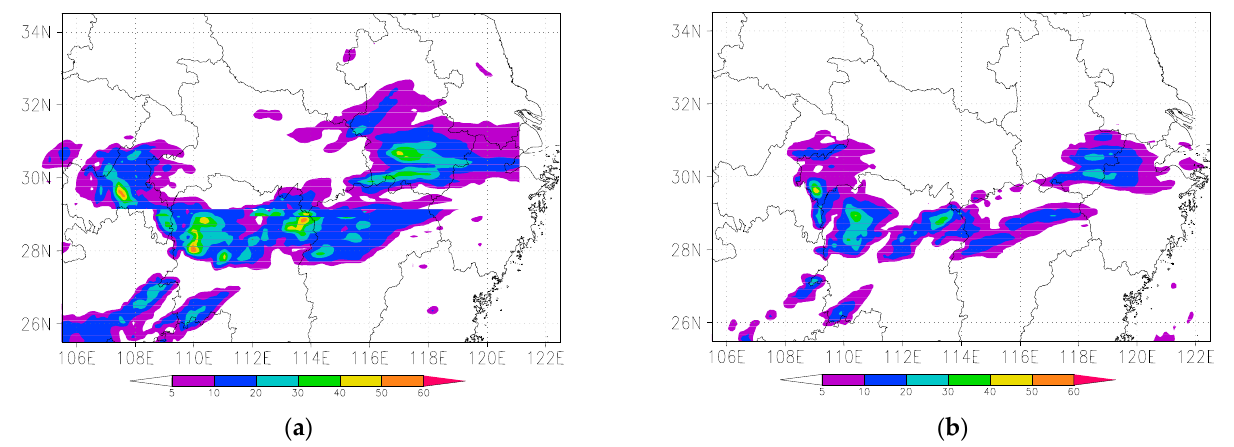
Figure 6. Ensemble spread of the 24 h cumulative precipitation (unit: mm). ( a ) ATM subset, ( b ) LSM subset. Table 2. Evaluation results of the 24 h precipitation forecasts, where listed quantities are regional averages of SPREAD, systematic error (absolute mean relative error; AMRE), and random error (normalised RMSE), and the areal percentage in the D 2 domain that has significant differences by Student’s t ‐ tests at the 0.10 significance level.